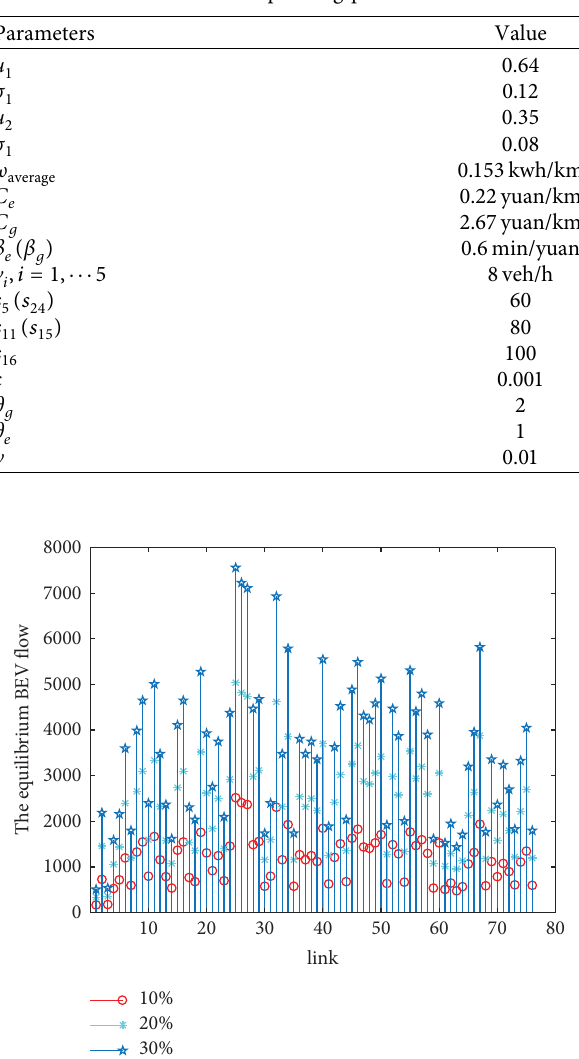
Figure 4: Te equilibrium BEV fow under diferent BEV market shares.